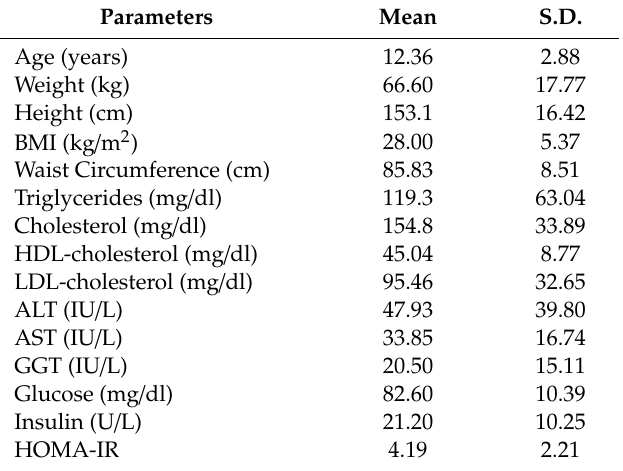
Table 1. Anthropometrical and metabolic patient’s characteristics ( n = 40).